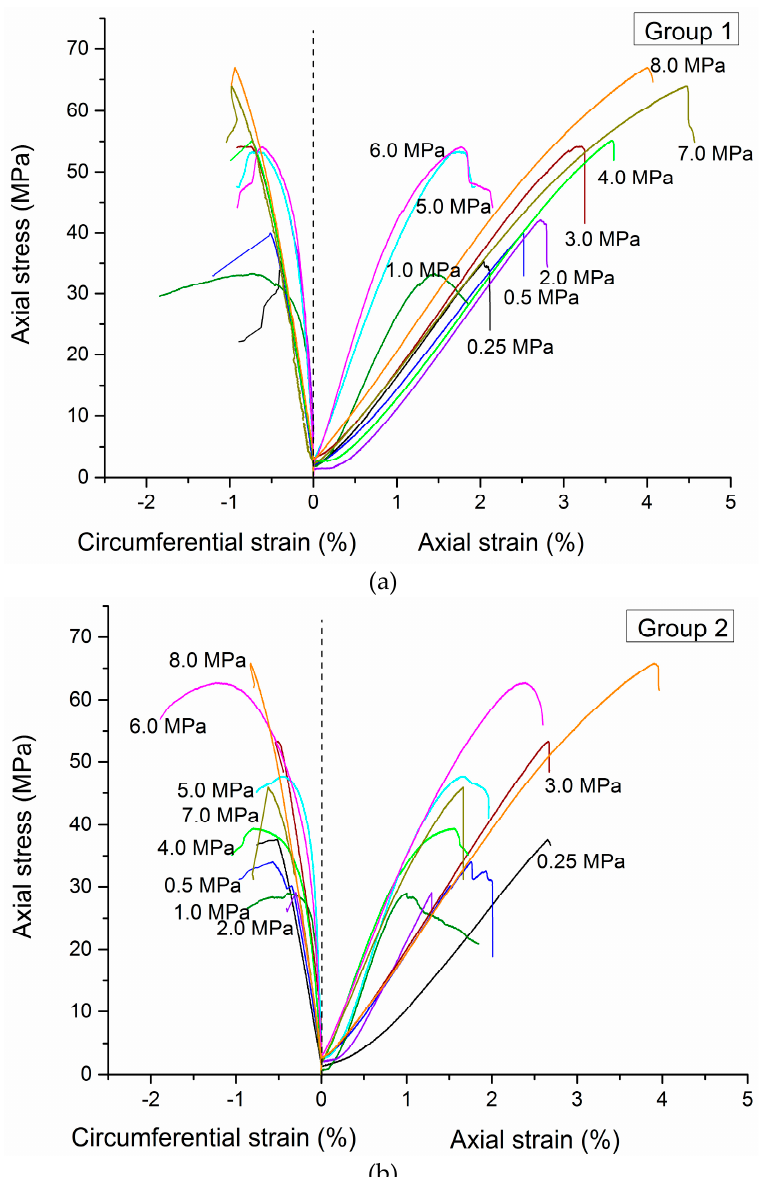
Figure 5. Axial and circumferential strain behavior of coal specimens under different confining stresses: ( a ) group 1; ( b ) group 2.